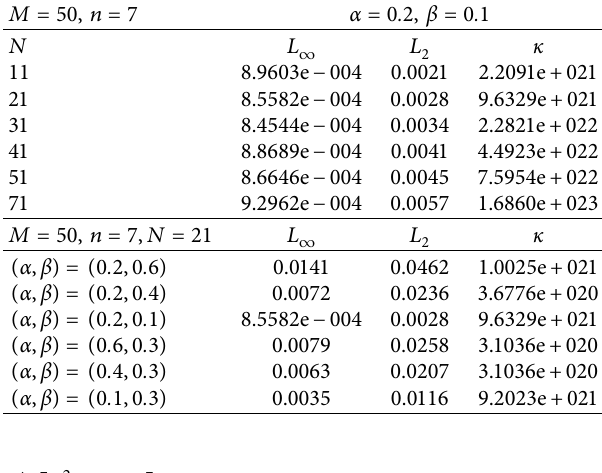
Table 1: Numerical results using the proposed numerical scheme corresponding to Problem